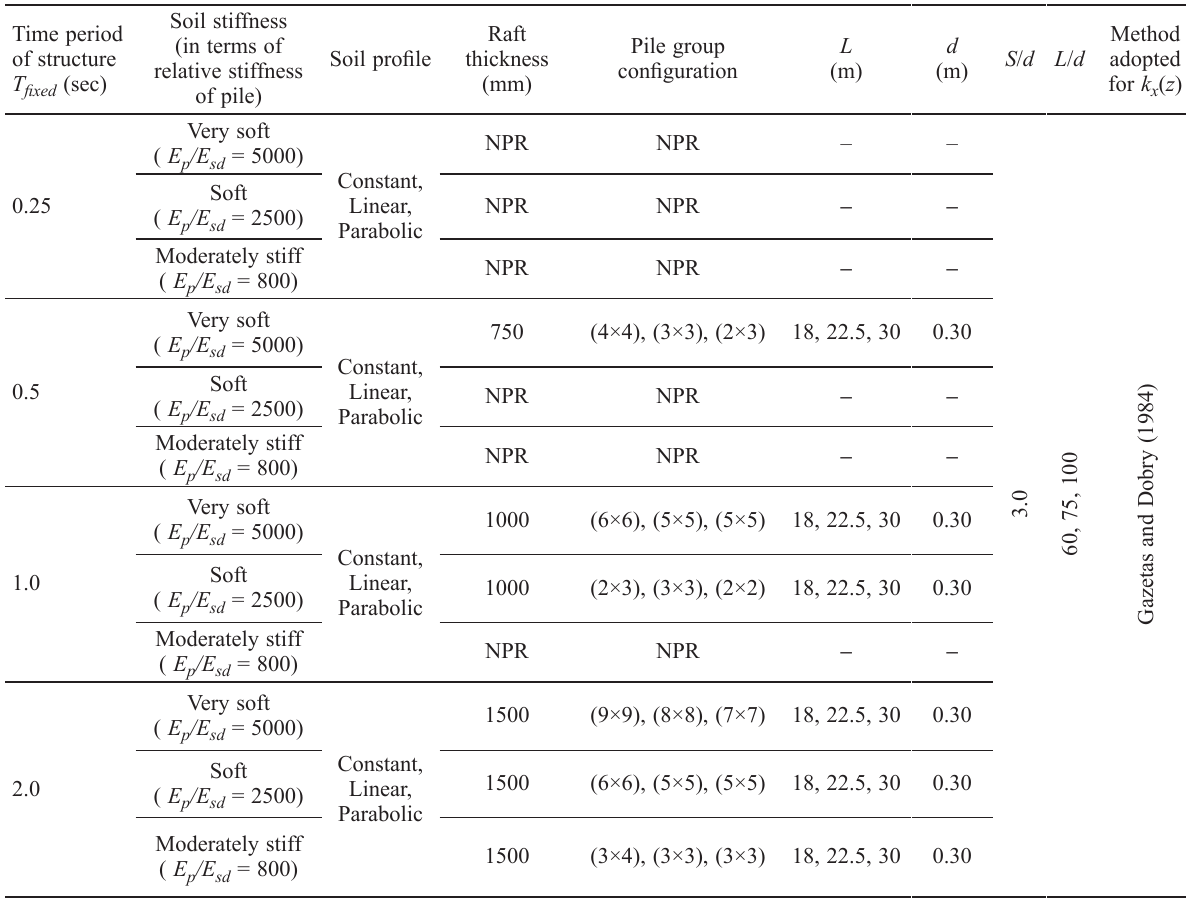
Table 4. Summary of case studies Time period of